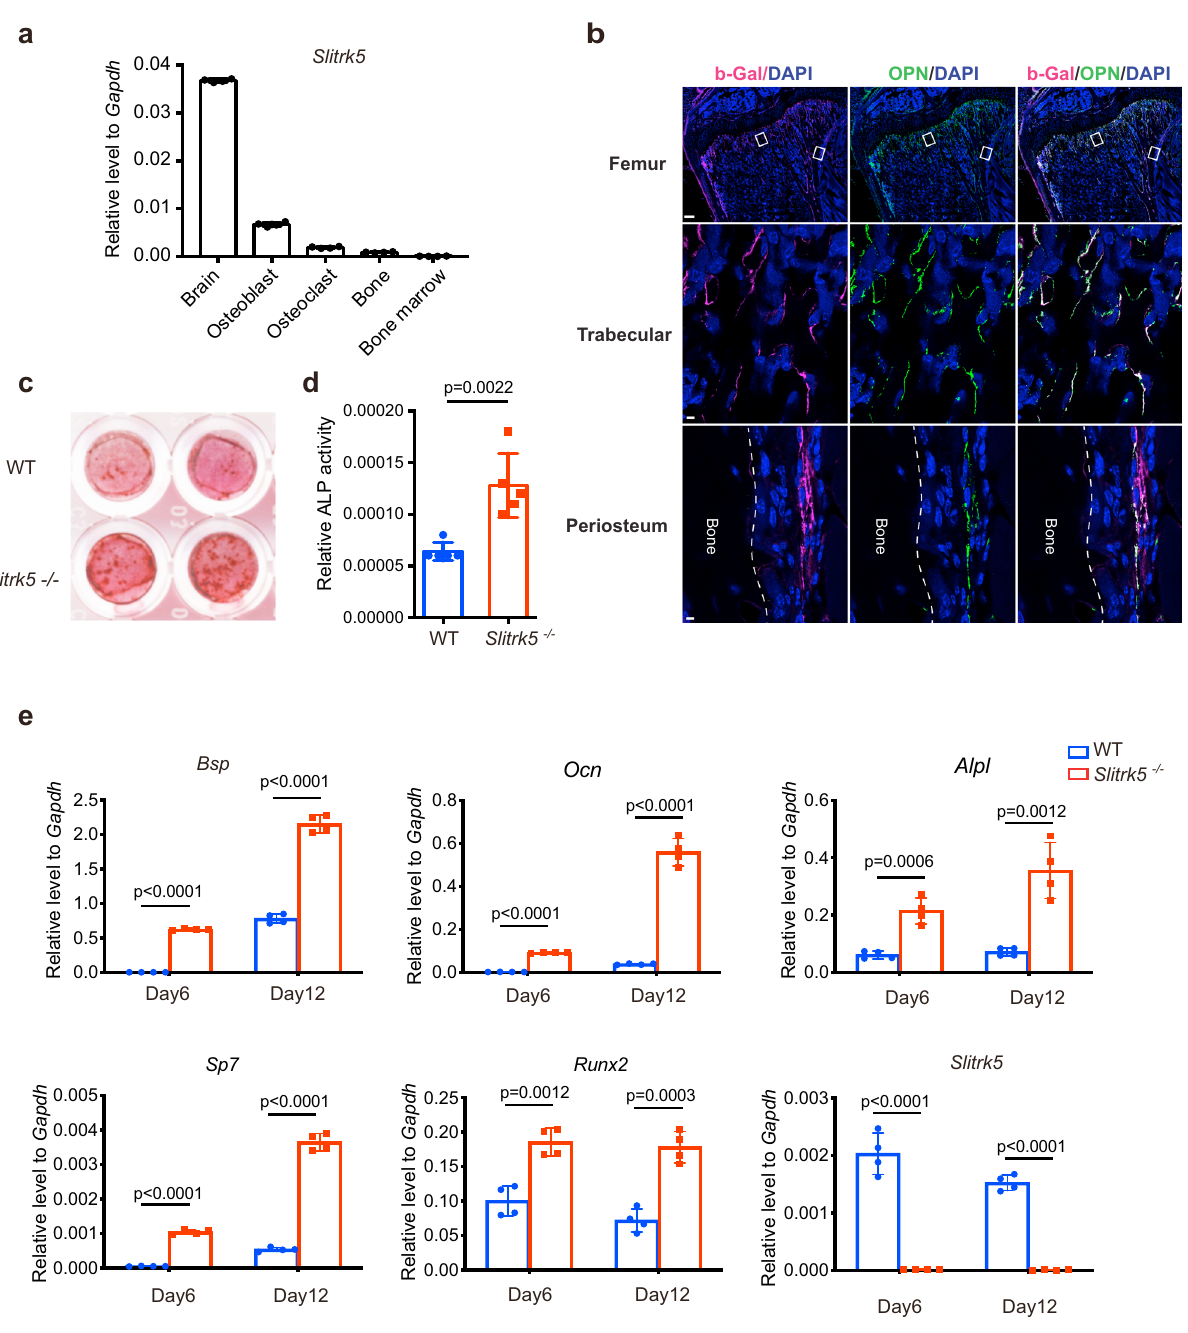
Fig. 1 Slitrk5 is expressed in osteoblasts and negatively regulates osteoblastogenesis. a Expression of Slitrk5 mRNA in indicated cells or tissues. Data are presented as mean ± s.d. n = 4 biologically independent samples. b Immuno fl uorescence staining of mouse femur sections with anti-beta-galactosidase and OPN antibodies, demonstrating the expression of Slitrk5 in osteoblasts. Data are representative of two independent experiments, scale bar = 200/10/ 10 µ m. c , d Primary osteoblasts from WT and Slitrk5 − / − mice were cultured in osteoblast differentiation medium. Mineralization activity was assessed by alizarin red staining ( c ) at day 14 of differentiation. Alkaline phosphatase (ALP) activity was measured at day 8 of differentiation ( d ). Data in ( d ) are presented as mean ± s.d. n = 5 biologically independent samples, two-tailed unpaired t test. e RT-PCR analysis of Slitrk5 and osteoblast marker genes expression at day 6 and day 12 of differentiation in WT and Slitrk5 − / − osteoblasts during differentiation. n = 4 biologically independent samples, two-tailed unpaired t test. Data are presented as mean ±